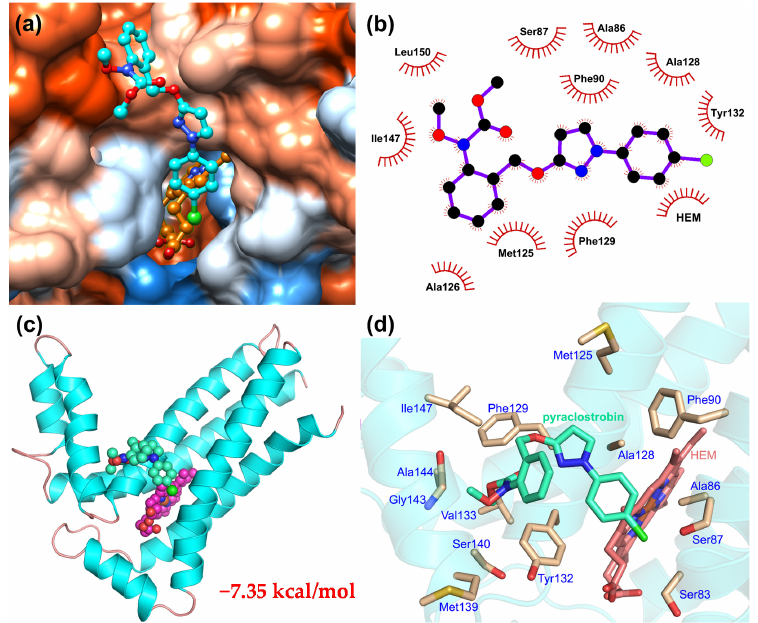
Figure 2. Binding mode of pyraclostrobin and CcCyt b protein. ( a ) Binding mode of pyraclostrobin, and hydrophobic and hydrophilic surfaces of CcCyt b protein. Blue and orange represent hydrophilic and hydrophobic regions, respectively. ( b ) Two-dimensional interaction of pyraclostrobin and CcCyt b, whereby red zigzag represents hydrophobic effect. ( c ) Binding position of pyraclostrobin and CcCyt b protein. ( d ) Interaction of pyraclostrobin and the amino acids of CcCyt b. Horticulturae 2021 , 7 , x